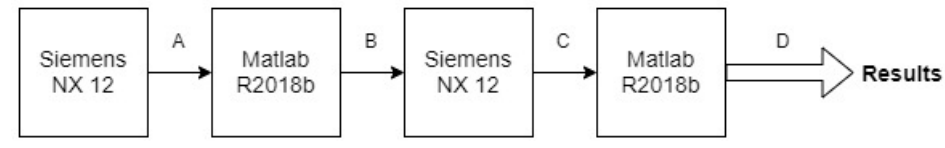
Figure 10. Optimization lay-up process. (A, B, C, D refers to process steps).